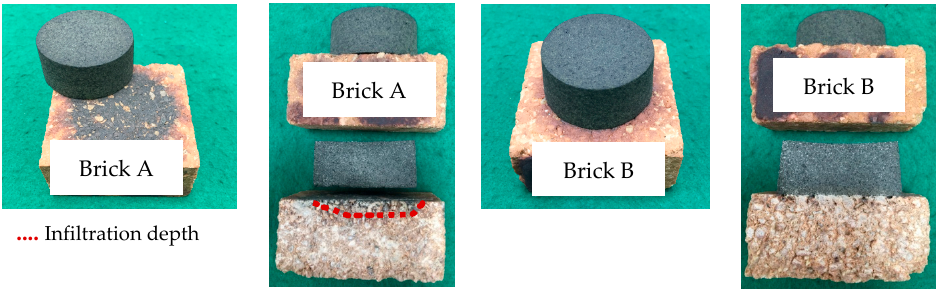
6 Figure 3. X-ray diffraction patterns of cement raw meals. ( a ) As received. ( b ) Modified. 3.2. Qualitative Coating Test The evaluation of adherence ability of the coating for the bricks A and B by the contact method described by Kosuka et al. [8] is shown in Table 4 for different raw meals. The test was performed in duplicate and the refractory samples were taken from the same brick. Brick B showed better coating adherence than brick A when the cement raw meal as received was used in the coating test. Indeed, the higher porosity and permeability of brick B contribute with a physical coating adherence. Moreover, the reaction of CaO from cement clinker with no reacted ZrO 2 from brick B, forms CaZrO 3 , which increases the connection between the clinker–brick interface [10] and contributes with a chemical coating adherence. However, when the modified cement raw meal was used, as proposed by Kosuka et al. [8], both bricks presented similar behavior with no coating adherence after first cycle, and the coating agent was easily removed after second and third cycles. The increasing of coating adherence with cycles was related with the excessive use of additions to cement raw meal. Table 4. Evaluation of contact coating test for the bricks A and B. Brick A B Classification after 1st, 2nd and 3rd Cycle Raw meal as received